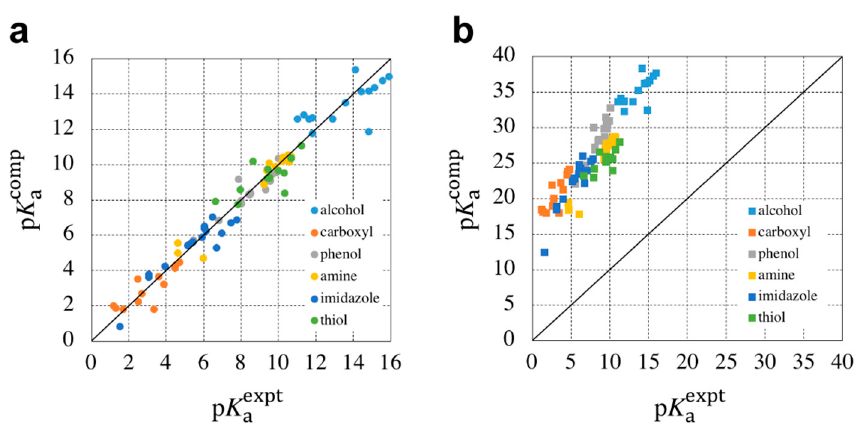
Figure 6. Comparison of the computed p K a values with the experimental values determined using ( a ) the LFC/3D-RISM-SCF, and ( b ) first-principles approach of the 3D-RISM-SCF. These figures are reprinted with permission from [28], Copyright 2018, Royal Society of